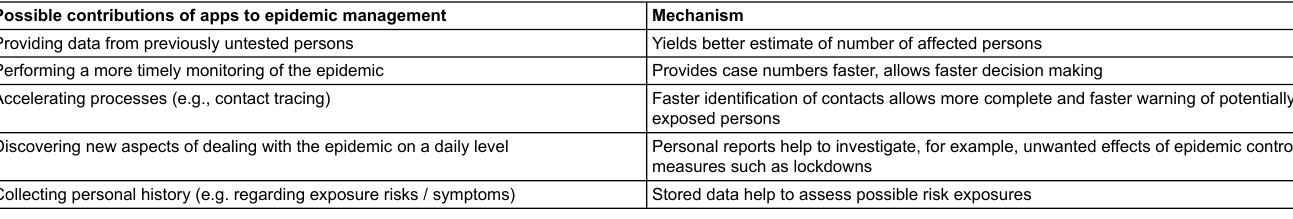
Table 2: Contributions of apps to epidemic control